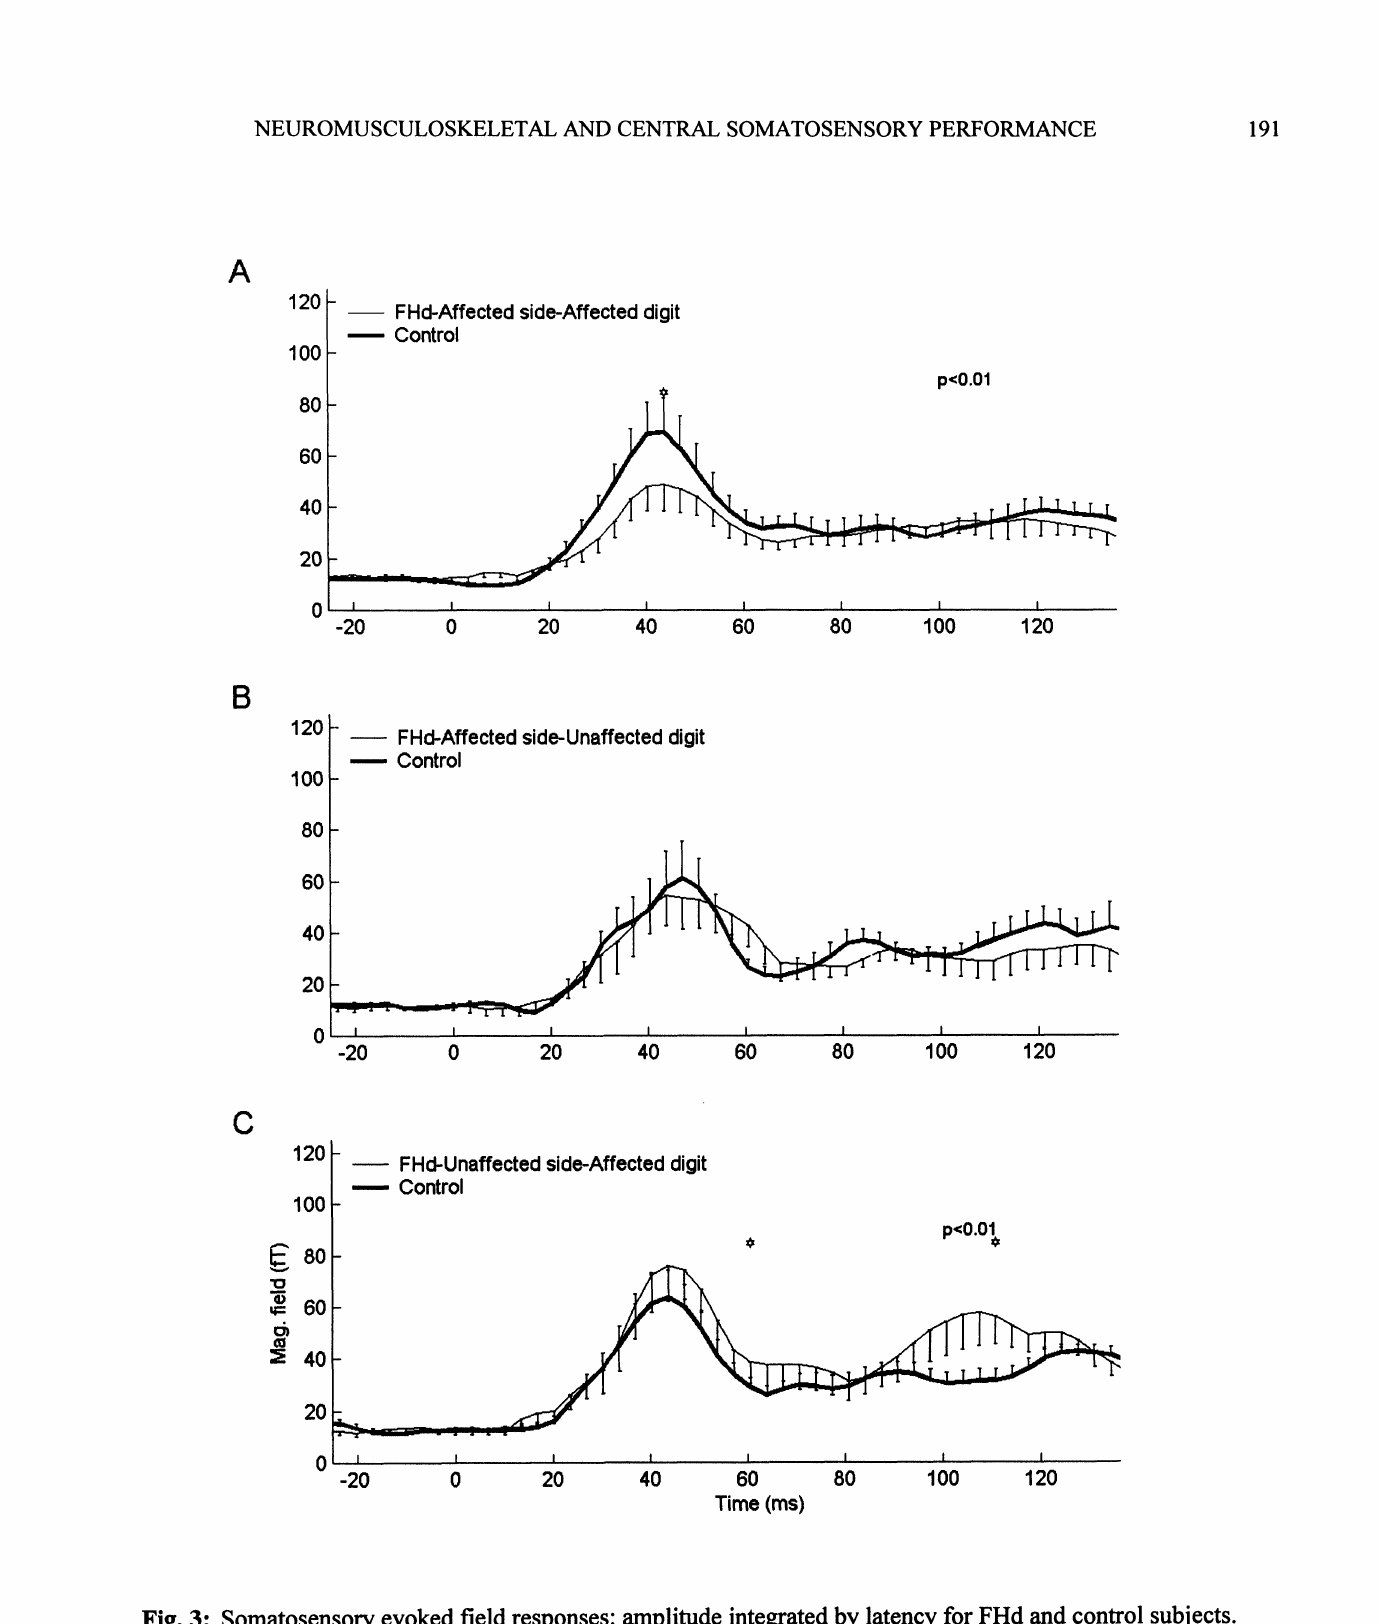
Fig. 3: Somatosensory evoked field responses: amplitude integrated by latency for FHd and control